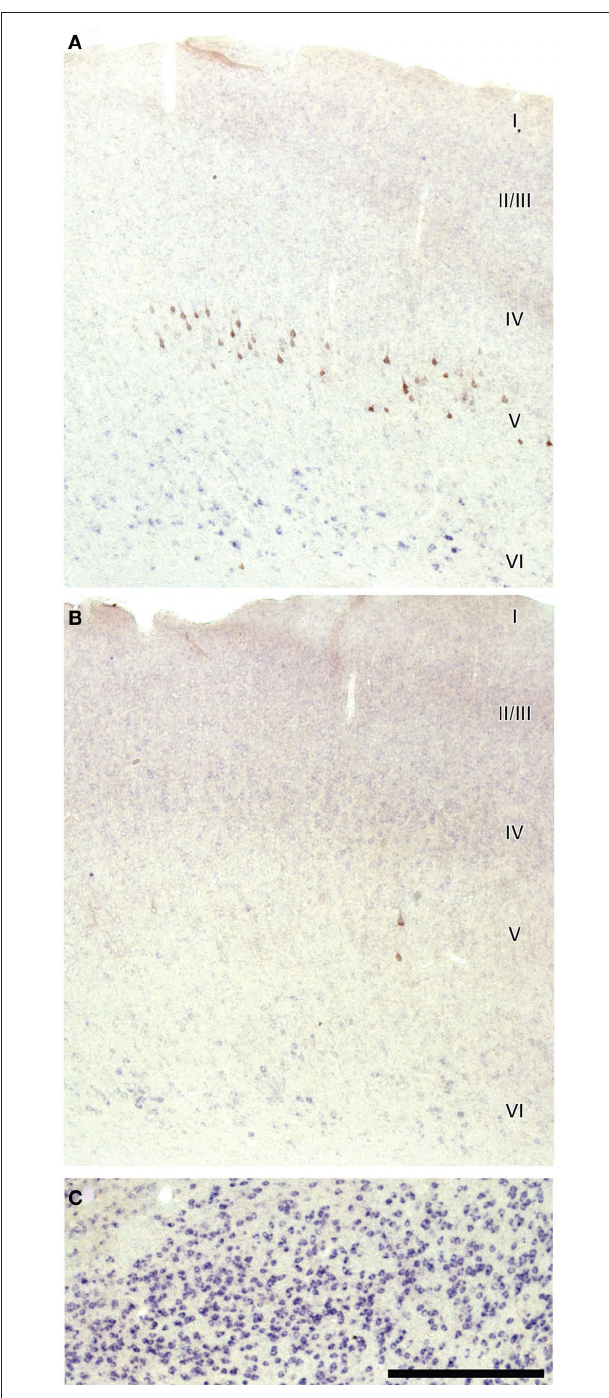
Figure 5 | Weak expression of VgLuT2 in layer 6 (Vi) of rostral auditory cortex in same case as Figure 4. Compared to Figure 4B , this section is developed to show weak expression and consequently some background labeling. Modest VGLUT2 expression is in layer 6 of ipsilateral cortex (A) and contralateral cortex (B) , but it is weak compared to the thalamus of the same section (C) . Labeling in layers 2/3 and 4 (II/III and IV) is slightly above background and less intense than layer 6. Lack of above background label in layer 5 suggests no FG + neurons are VGLUT2 positive. Scale bar: 500